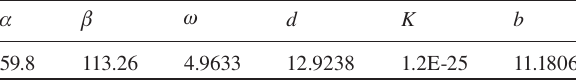
Table 1 Parameters of ISO standard ( ± 45)